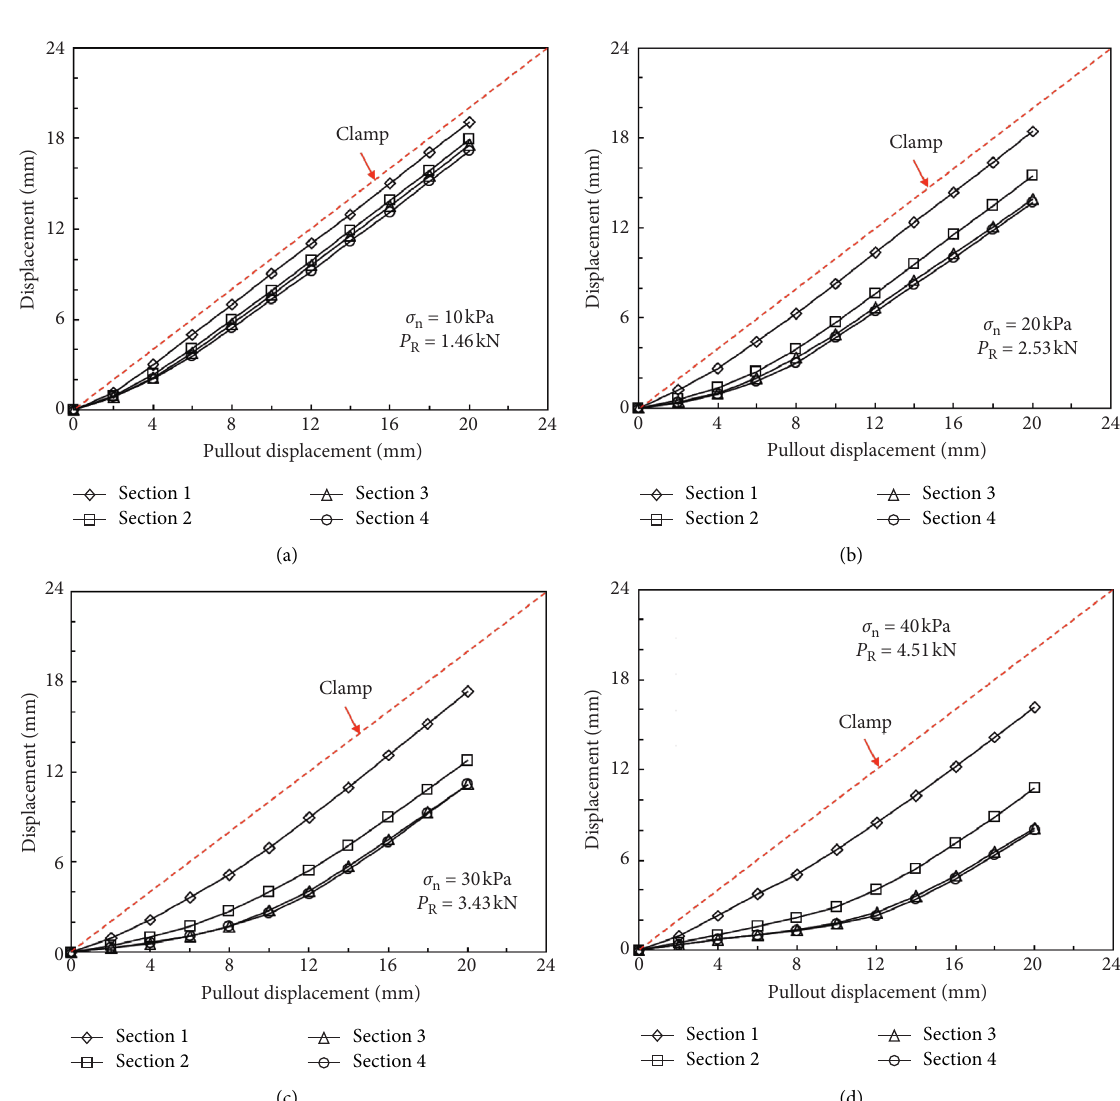
Figure 7: Displacements of measuring sections versus pullout displacement.